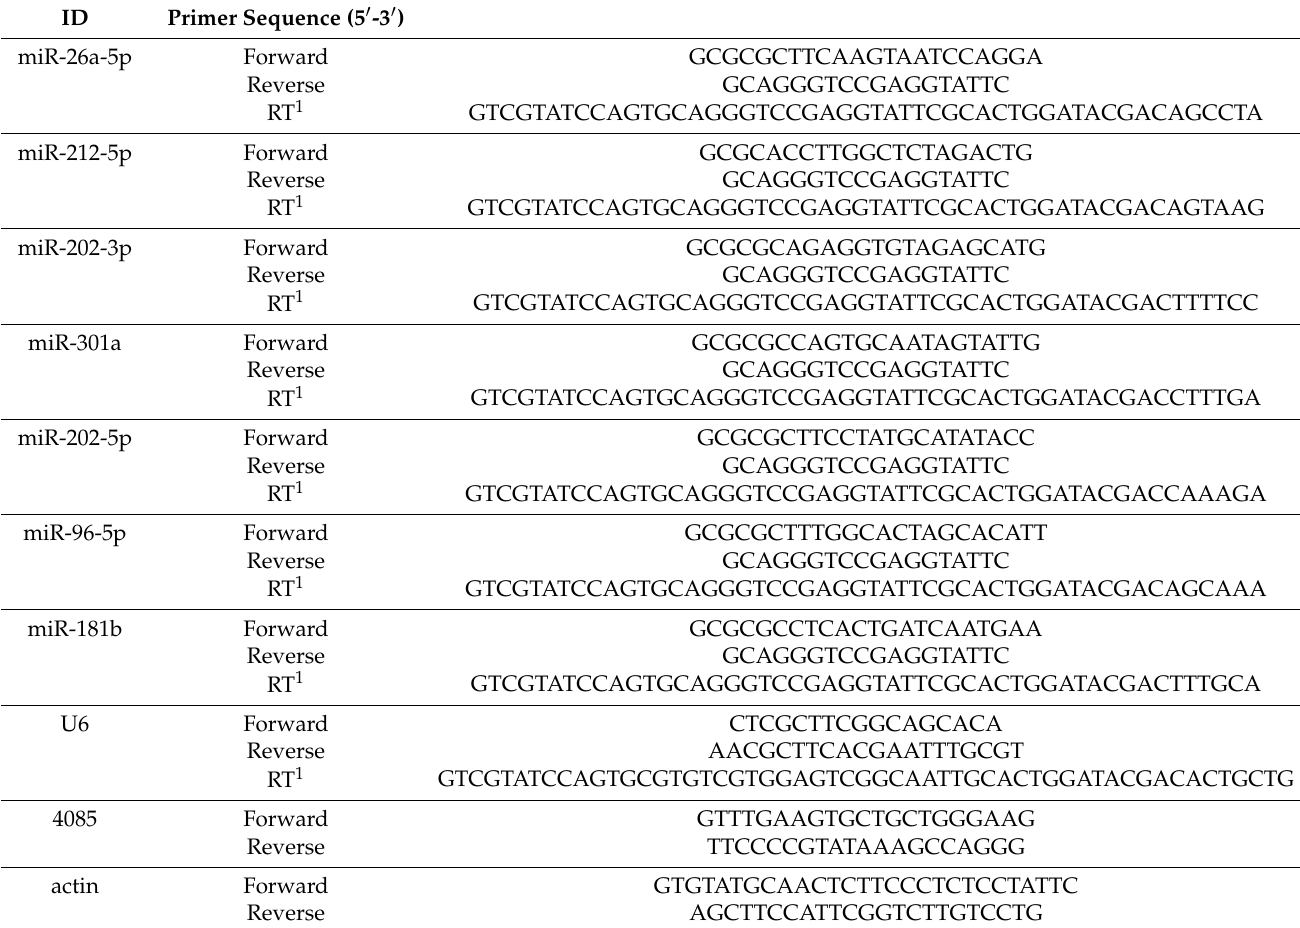
Table 1. The primers used for amplification of sex specific markers and RT-qPCR of selected miRNAs. ID Primer Sequence (5 (cid:48) -3 (cid:48) )